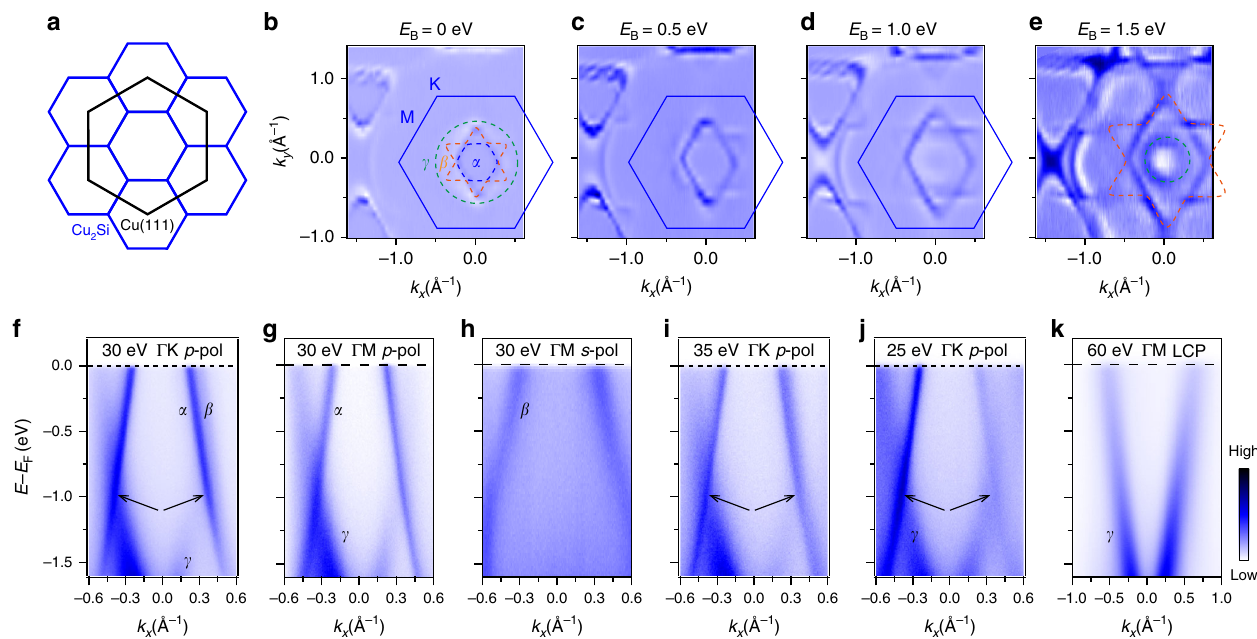
Fig. 3 ARPES results for monolayer Cu 2 Si on Cu(111). a Schematic drawing of the Brillouin zones of Cu 2 Si (blue hexagons) and Cu(111) (black hexagon). As ffiffiffi p ffiffiffi p (cid:3) (cid:4) ´ the lattice of Cu 2 Si is 3 3 R30° with respect to the Cu(111)-1 × 1 lattice, the K point of Cu(111) is located at the Γ point of the second Brillouin zone of Cu 2 Si. b – e Second derivative CECs measured using 30-eV p -polarized photons. Three closed contours have been observed: a hexagon, a hexagram, and a circle, as indicated by the dashed lines. f , i , j ARPES intensity plots along the Γ -K direction measured with different photon energies: 30, 35, and 25 eV, respectively. The black arrows mark the position of the crossing points. g , h ARPES intensity plots along the Γ -M direction measured with p and s polarized light, respectively. k ARPES intensity plots along the Γ -M direction measured with 60-eV circularly polarized light. The γ band is clearly observed while the α and β bands are suppressed